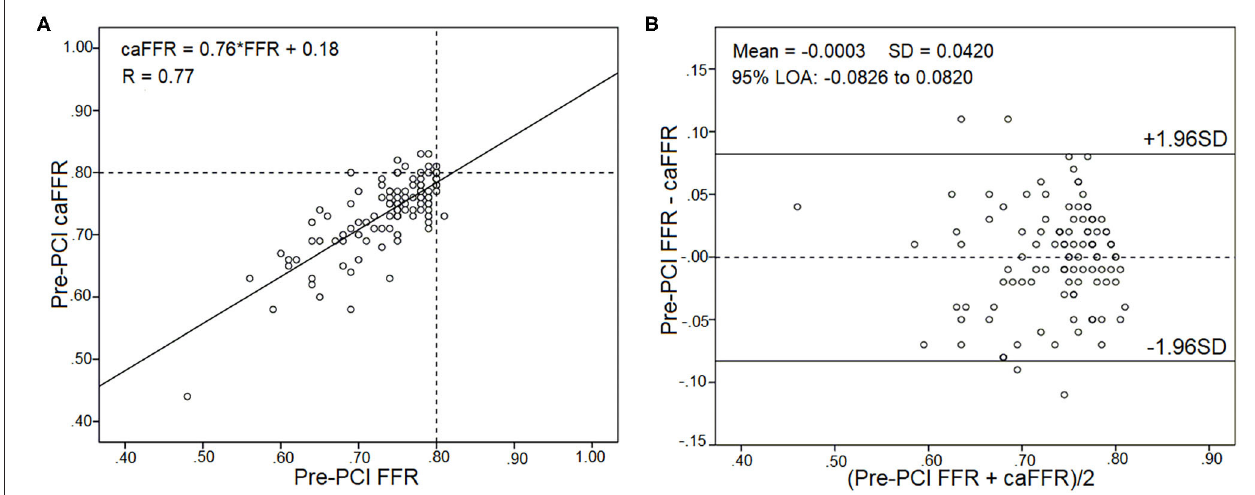
FIGURE 4 | Correlation and agreement between pre-PCI wire-based FFR and caFFR values ( n = 105). (A) Strong correlation between pre-PCI wire-based FFR and caFFR values (caFFR = 0.76 × FFR + 0.18, R = 0.77, 95% CI: 0.53–0.78). (B) Good agreement between pre-PCI wire-based FFR and caFFR values by the Bland–Altman analysis (bias: − 0.0003 ± 0.0420; 95% LOA − 0.0826 to 0.0820). CI, confidence interval; LOA, limits of agreement; LAD, left descending artery; FFR, fractional flow reserve; PCI, percutaneous coronary intervention; caFFR, coronary angiography-derived FFR.